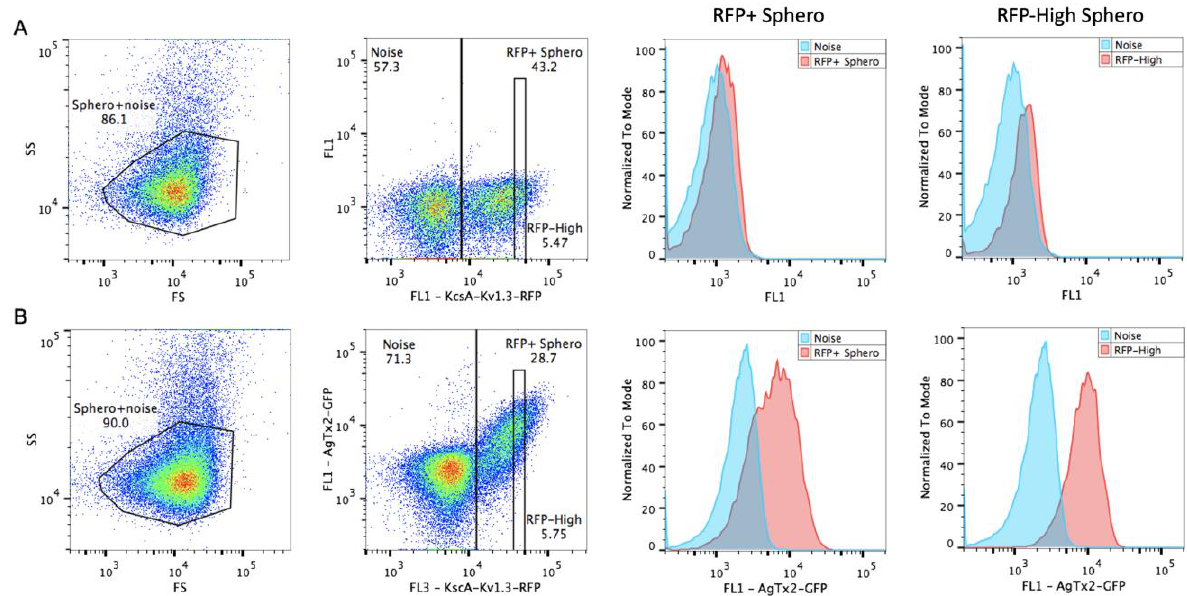
Figure 2. Analysis of ligand binding to spheroplasts by conventional flow cytometry approaches. Cells before ( A ) and after ( B ) incubation with AgTx2-GFP are shown. The first column represents gating on spheroplasts based on light scattering. Spheroplast regions are indicated. The second column shows dot plots of spheroplasts according to RFP and GFP fluorescence. All spheroplasts are RFP-positive, while RFP-negative events are debris and system noise. Gates for all RFP-positive events (RFP+) and events within the narrow RFP range (RFP-High) are presented. Histograms of spheroplast distribution according to the AgTx2-GPF bindings (red), compared to the noise (blue) in the same sample, are presented for RFP+ and RFP-High spheroplasts, respectively.